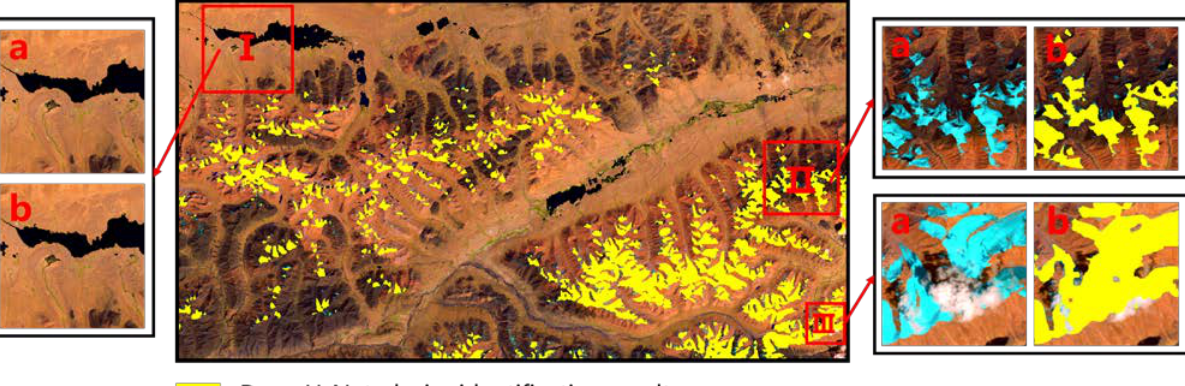
Figure 8. Deep U-Net glacier identification result. (a): original image. (b): identification